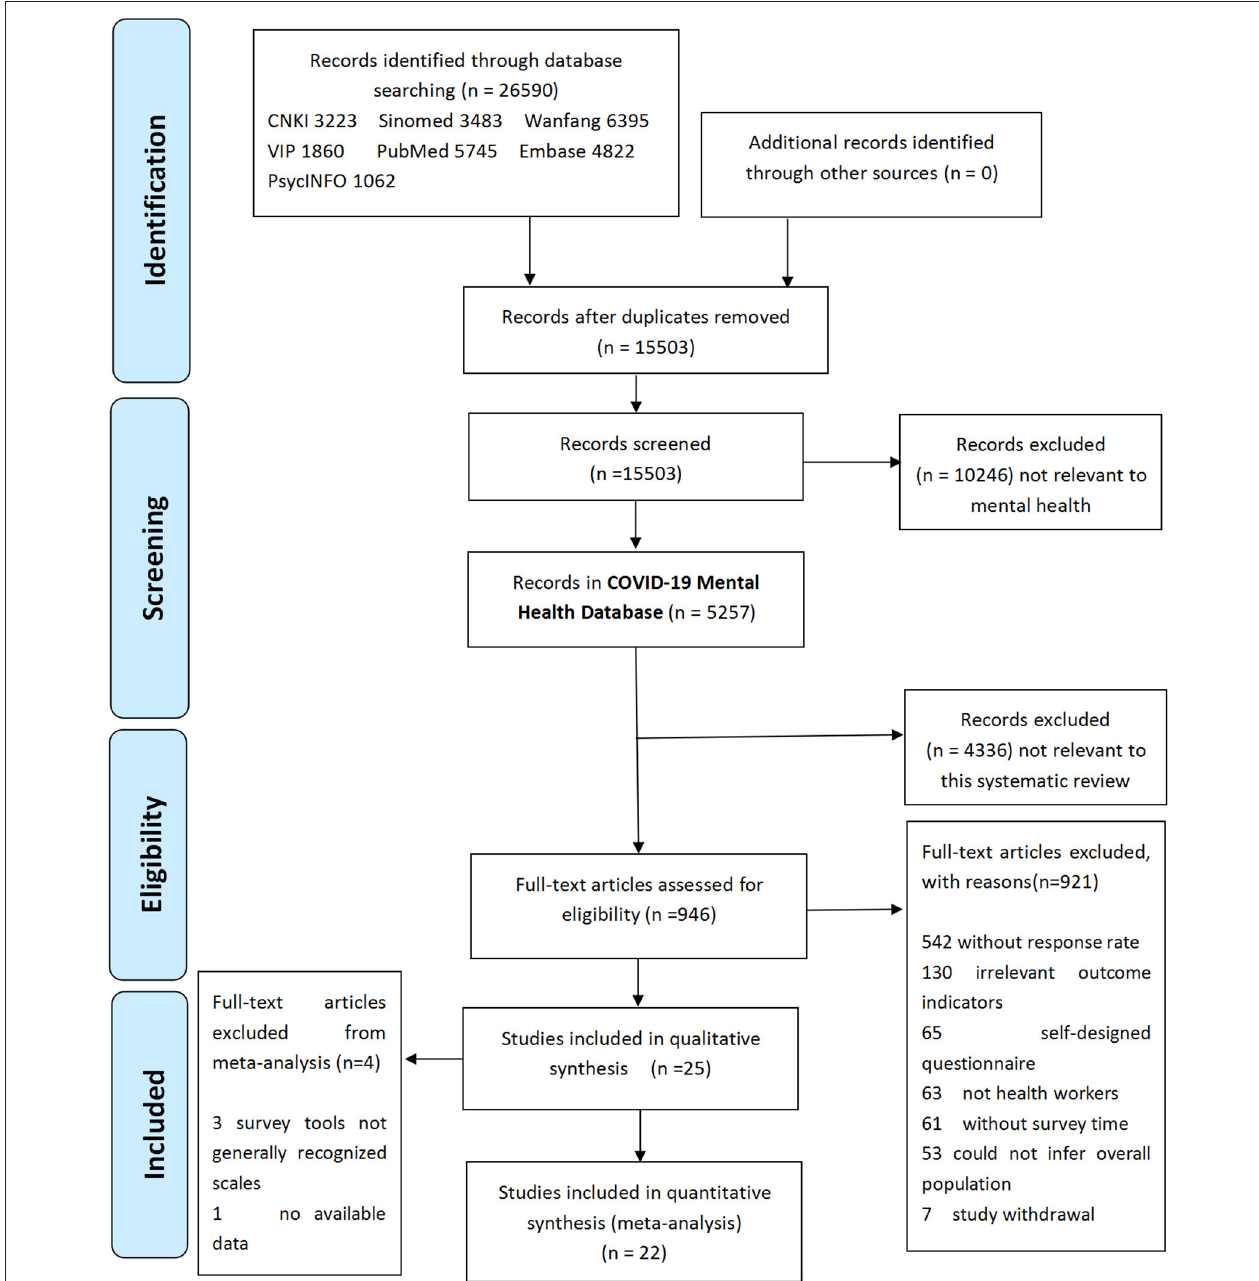
FIGURE 1 | Flow diagram of the selection of studies for the systematic review and meta-analysis.